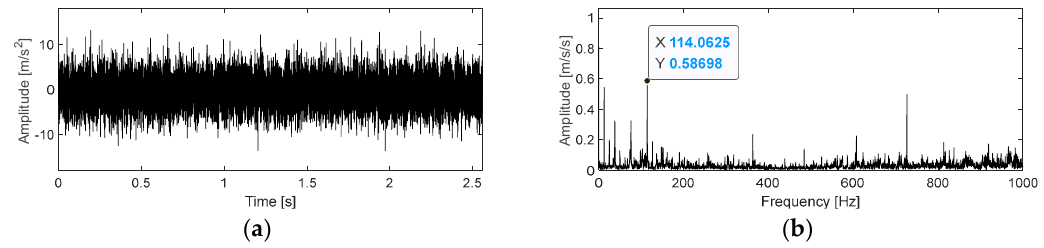
Figure 12. The engineering data with its envelope spectrum result: ( a ) Time domain waveform of the